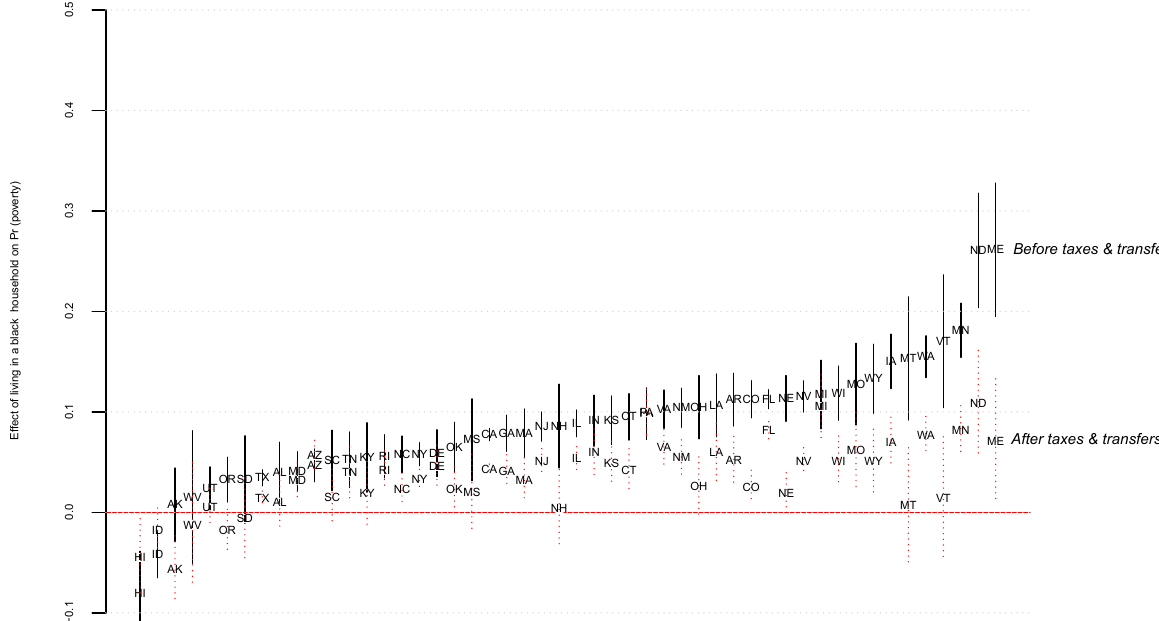
Figure 9: Black penalty: effects of living in with a black head on Pr (poverty) before and after taxes and transfers (2012–2016 CPS). Adjustments for SNAP, SSI, and TANF underreporting were made using the Urban Institute Transfer Income Model (TRIM). Effects represent coefficients from varying slope linear probability models predicting SPM poverty. The nonvarying slopes in the model are year fixed effects and a control for metropolitan and/or nonmetropolitan status. States are indicated by their postal code